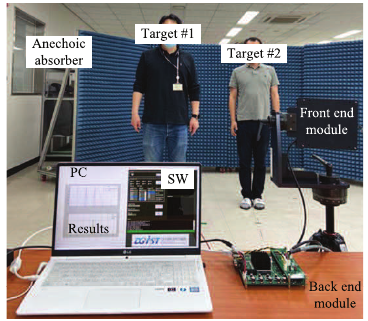
Figure 14. Experiment